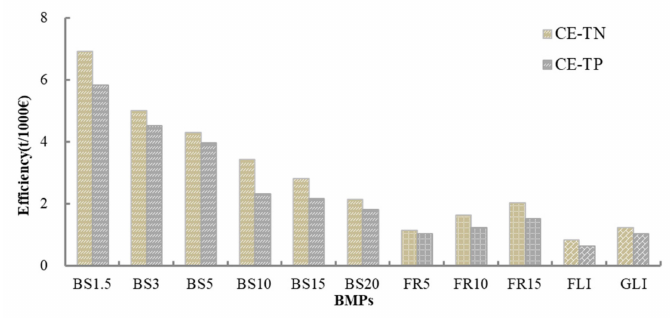
Figure 11. Cost-e ff ectiveness of BMPs considering TN and TP loads reduction and total